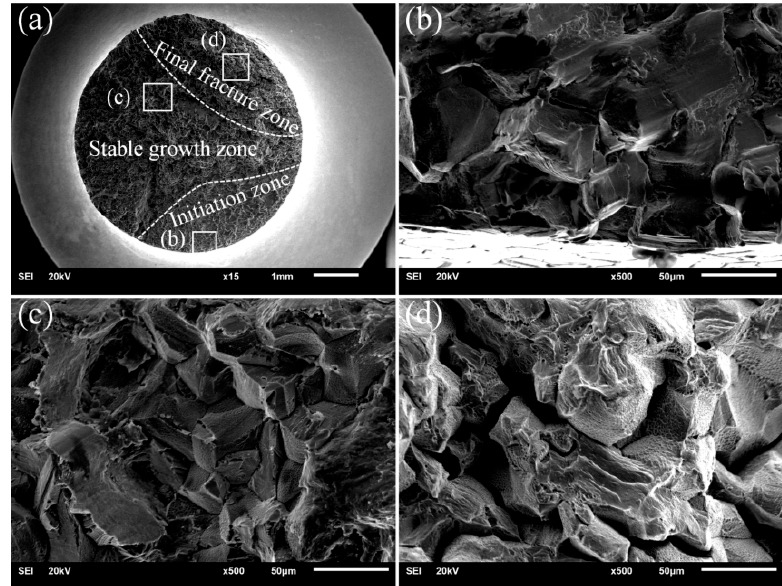
Figure 7. Fracture observations of a constant load specimen: ( a ) Overview of the fracture; ( b ) Crack initiation zone; ( c ) Crack stable growth zone; ( d ) Final fracture zone.